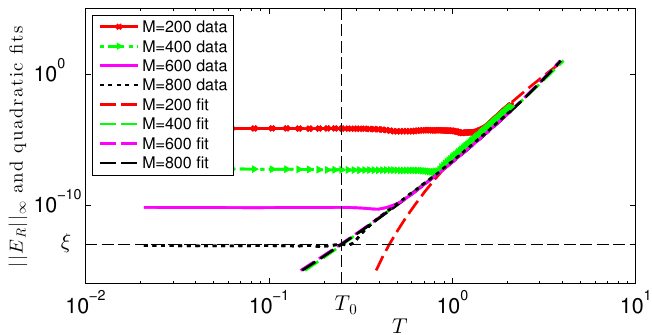
|| Figure 5. || E in the four-pole example with M = 200 , 400, 600 and 800 together R ∞ with their extrapolated quadratic fits. The vertical dashed line indicates the exact time delay T = 0 . 25 , while the horizontal dashed line indicates the level of filtering of singular values 0 given by ξ = 10 − 13 .